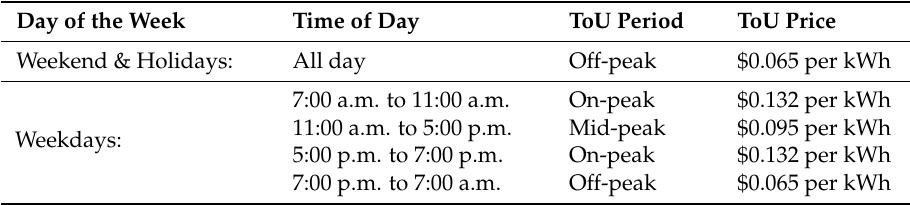
Table 2. The price assumption of electricity following the time of use (ToU) schema [33]. Day of the Week Time of